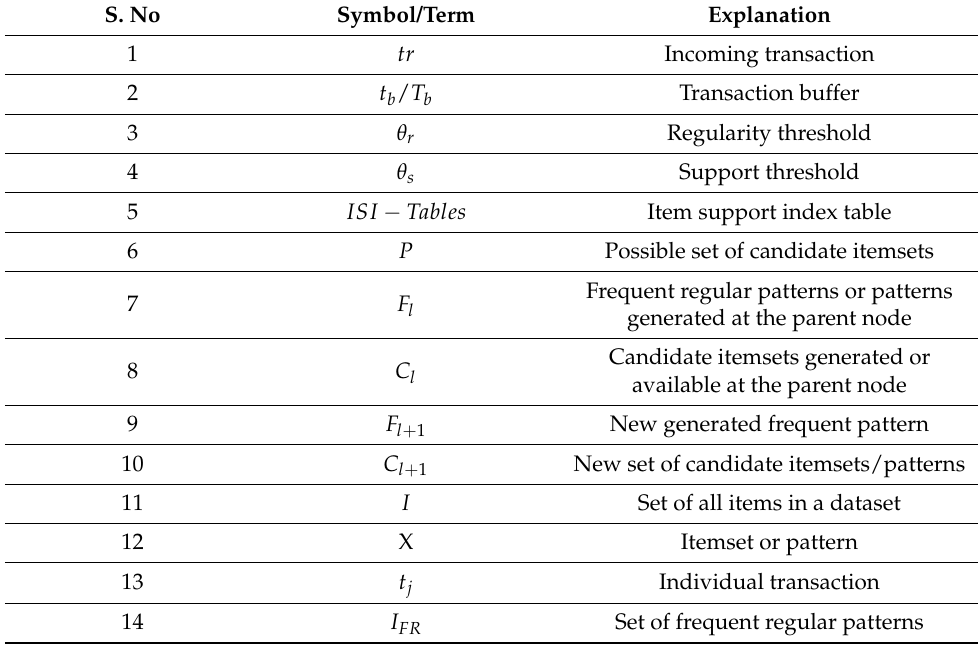
Table 2. Introduction and explanation of the notions used in the mathematic